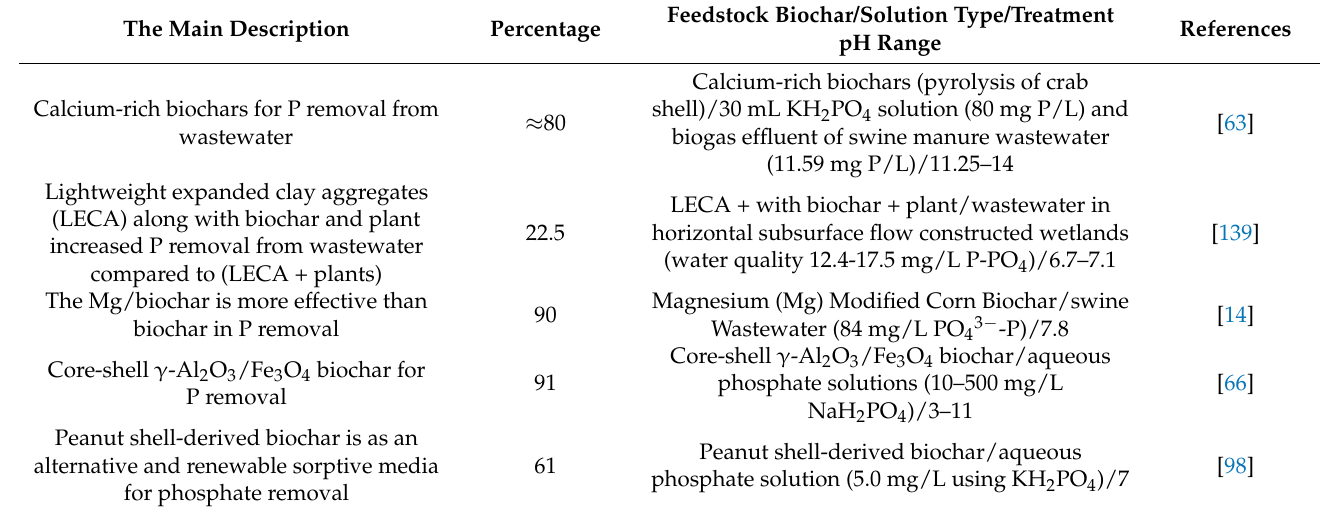
Table 4. P removal efficiency (%) of modified-biochar materials applied on different wastewater